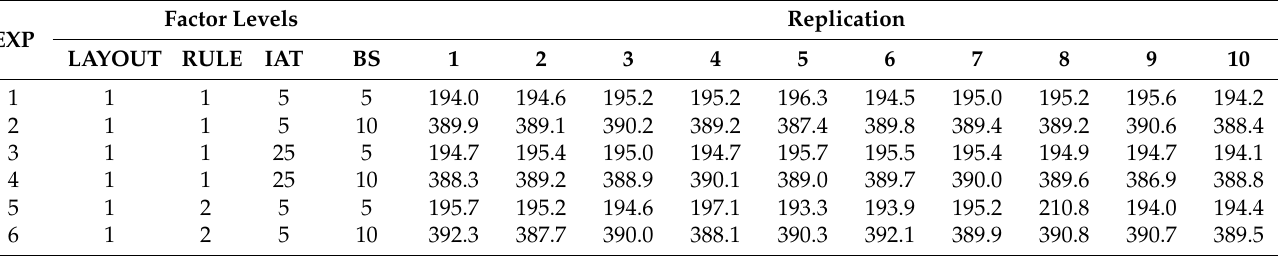
Table A5. TT simulation results according to